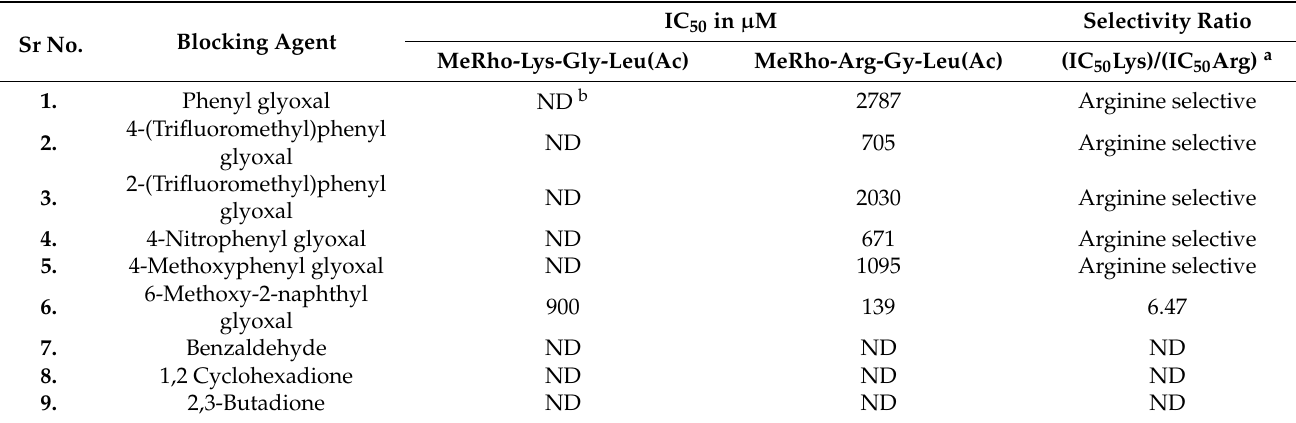
Table 2. The selectivity of blocking agents for